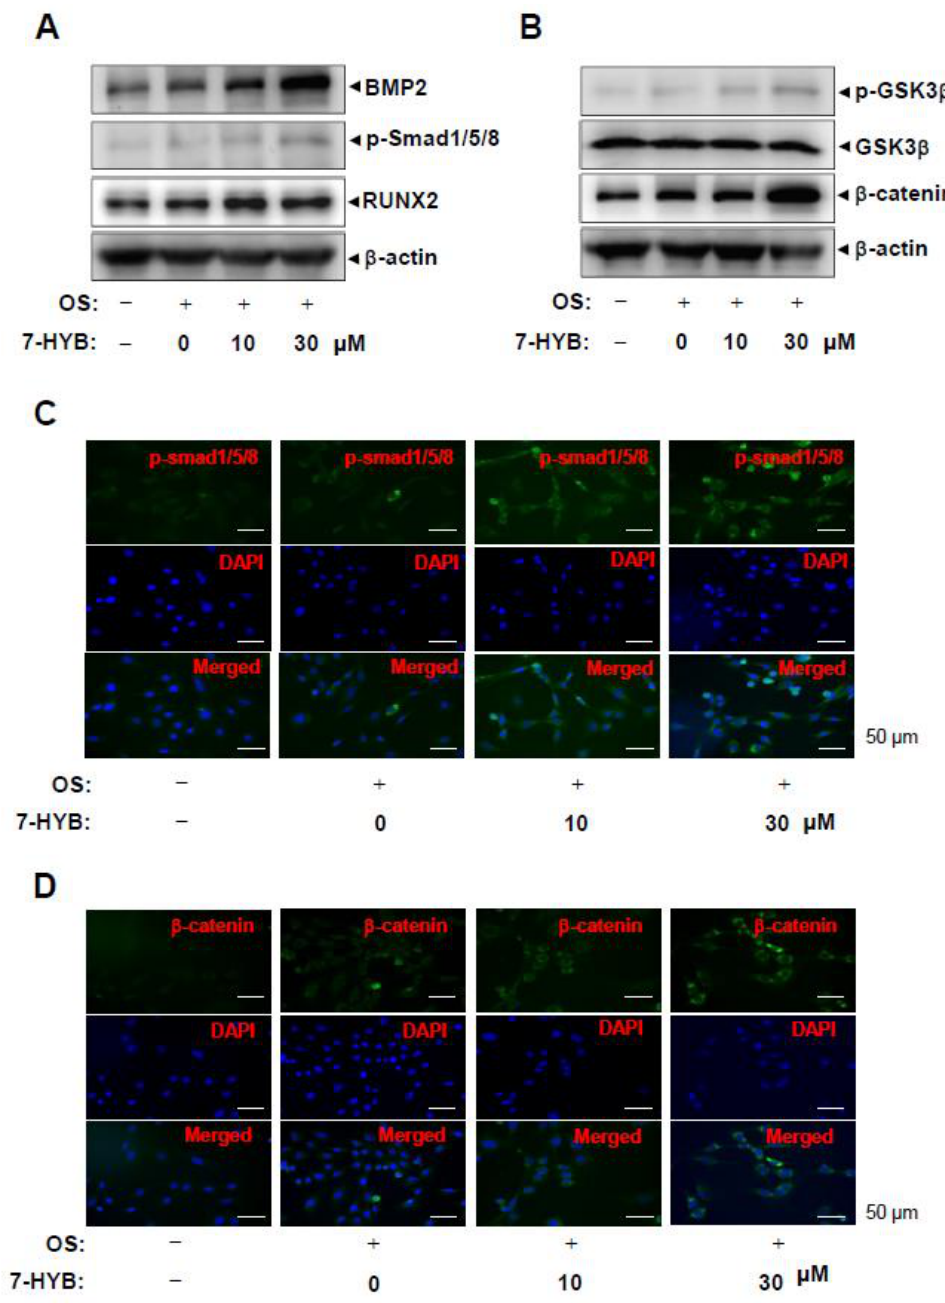
Figure 5. Effect of 7-HYB on the BMP2 and β-catenin pathways during osteoblast differentiation. ( A , B ) After preosteoblasts were cultured with OS with 7-HYB for 24 h, BMP2, p-Smad1/5/8, RUNX2, and β-actin ( A ), and p-GSK3β, GSK3β, β-catenin, and β-actin ( B ) were assessed by Western blot analysis. β-actin was used as a loading control. ( C , D ) After 24 h, p-Smad1/5/8 was immunostained with rabbit anti-p-Smad1/5/8 antibody and Alexa-Fluor 488-conjugated secondary antibody ( green ). Then, the cells were counterstained with DAPI ( blue ). The bottom panels show the merged images of the top and middle panels .